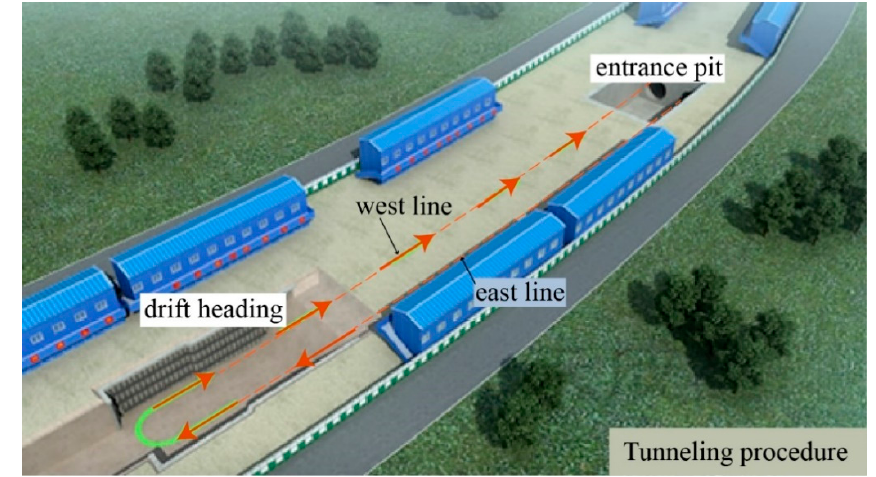
Figure 3. Overview of the URUP tunneling procedure.